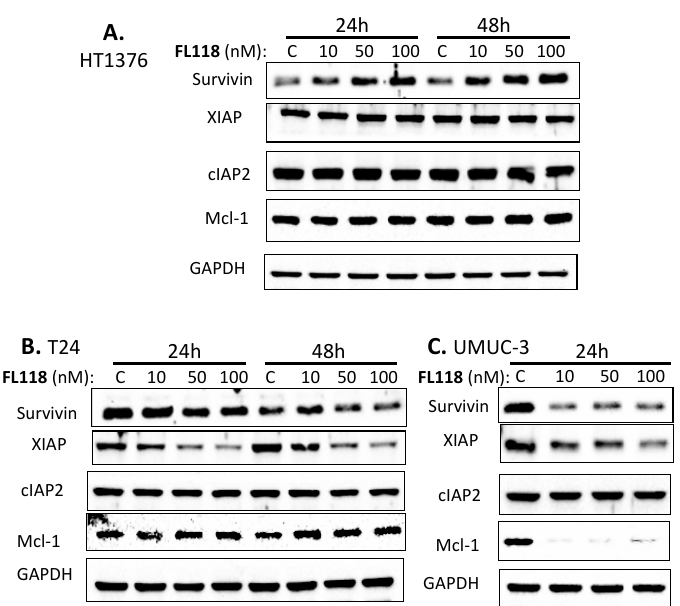
Figure 3. Inhibition of survivin, Mcl-1 and/or XIAP by FL118 in bladder cancer cell lines by FL118. Cells were treated with DMSO or 10–100 nM FL118 for 24 h and/or 48 h, as shown, followed by Western blot analyses to determine the expression of survivin, Mcl-1, XIAP and cIAP2. ( A ) In HT1376 cells, FL118 treatment did not inhibit any of these anti-apoptotic proteins. ( B ) T24 cells showed inhibition of XIAP and survivin after FL118 treatment. ( C ) FL118 treatment showed strong inhibition of Mcl-1, survivin and XIAP in UMUC-3 cells after FL118 treatment. GAPDH shown in A, B and C is the internal control of total protein-loading.